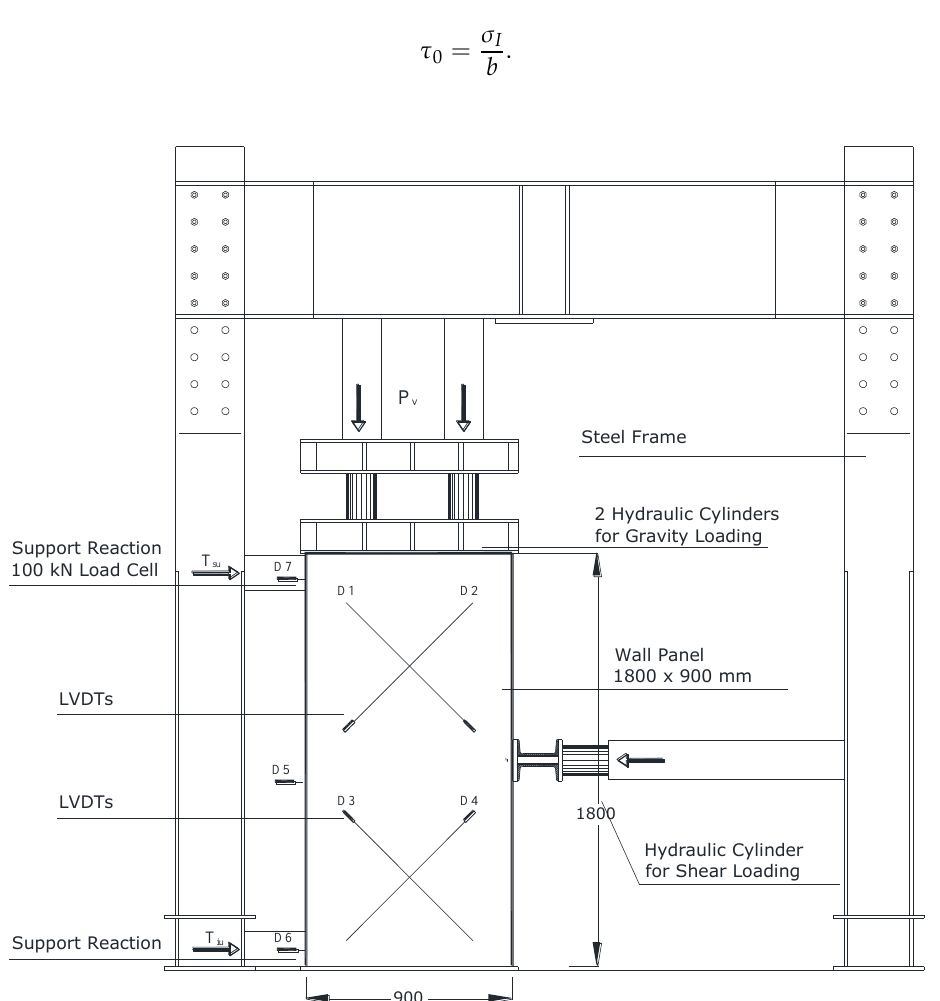
Figure 21. Shear compression test setup (dimensions in mm). LVDTs: Linear Variable Figure 21 Shear compression test setup (dimensions in mm). LVDTs: Linear Variable Differential Di ff erential Transformers